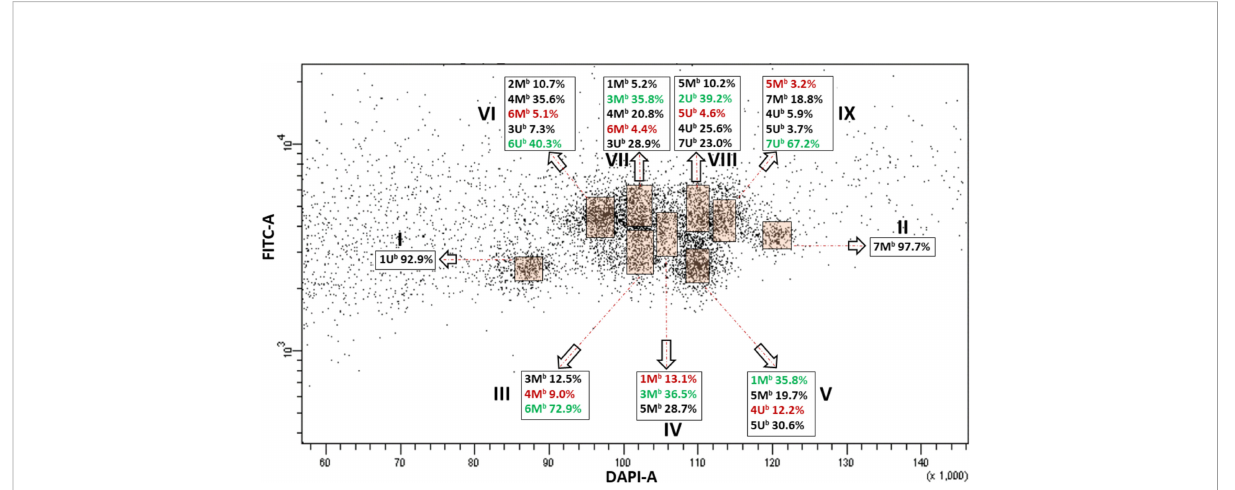
FIGURE 1 Bivariate fl ow karyotype (DAPI-A vs. FITC-A) of Ae. biuncialis acc. MvGB382. Flow cytometric analysis of DAPI stained mitotic chromosomes labeled by FISHIS with GAA 7 -FITC probe discriminated nine chromosome populations (I – IX) representing the whole genome of the species. Chromosomes in the sort windows (brown) were sorted onto microscope slides and classi fi ed by FISH. The red and green numbers within the chromosome content of the sorted populations (black rectangles) refer to the lowest and the highest purities, respectively. x-axis, relative DAPI fl fl uorescence. y-axis; relative GAA 7 -FITC